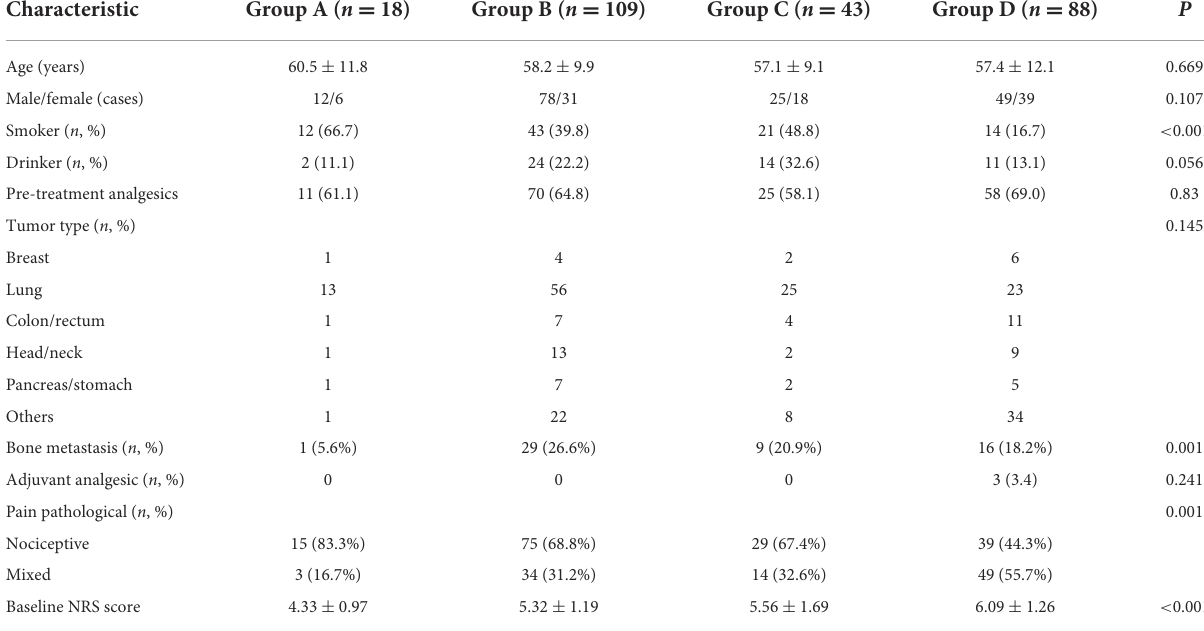
TABLE 1 Patient demographics and baseline clinical characteristics.